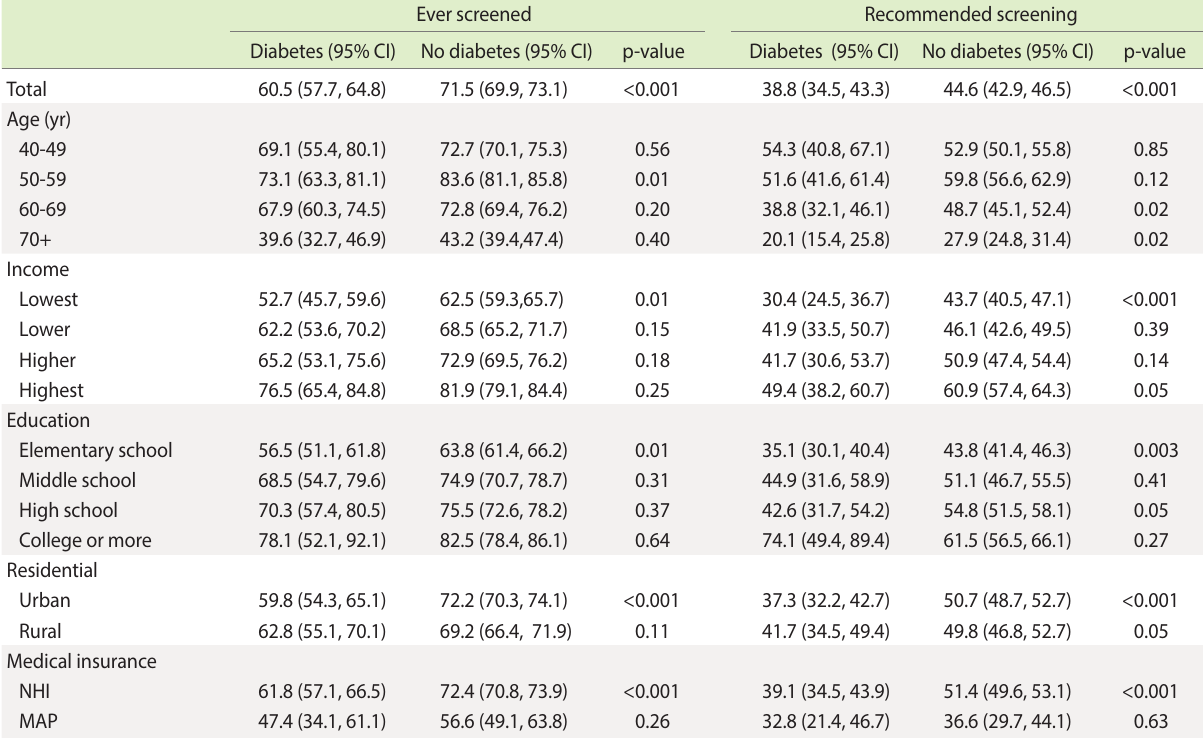
Table 3. Breast cancer screening rate in diabetic and non-diabetic participants (ever screened and recommended screening) Ever